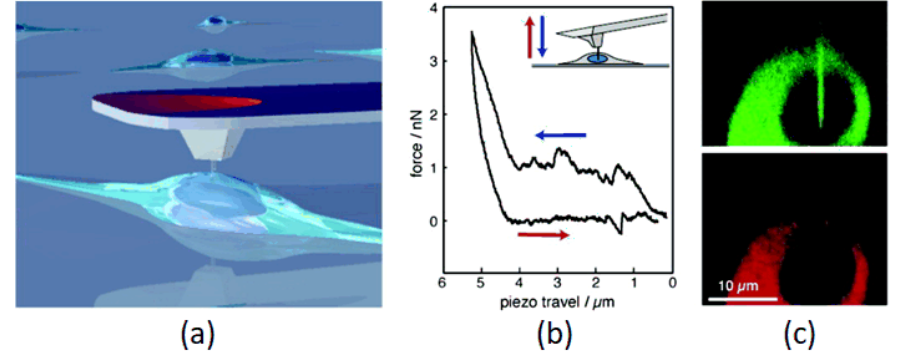
Figure 8. Nanoscale operation of a living cell using AFM. ( a ) Schematic representation of a nanoneedle on the AFM tip over a living cell. ( b ) Force-distance curves during approach and retraction from a melanocyte. ( c ) Cross-section images for green and red emission processed from confocal slices. Reproduced and adapted with permission from [20].